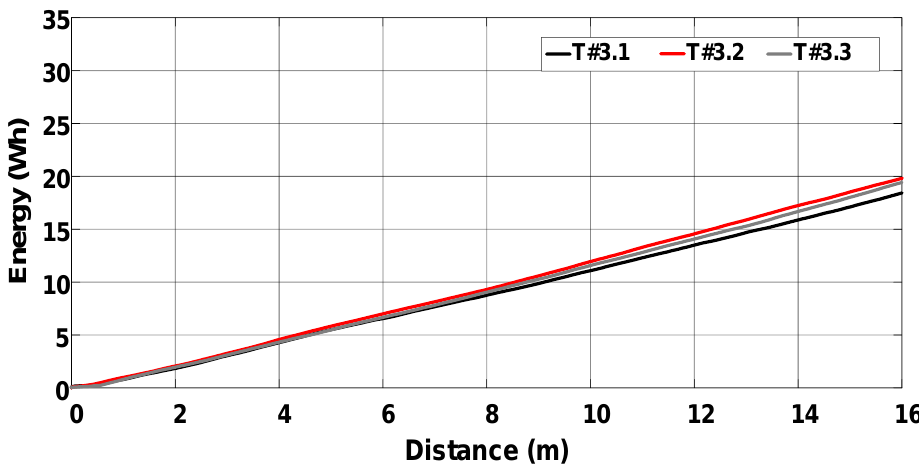
Figure 29. Power consumption during the trial sessions carried out on firm soil with the slip auto- matically adjusted by the proposed control scheme.